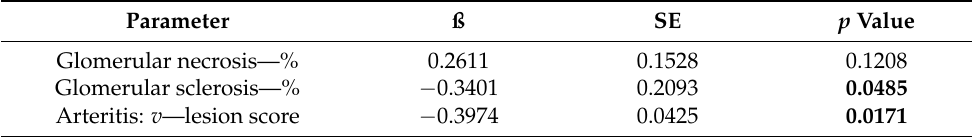
Table 6. Multiple regression analysis for variables associated with circulating